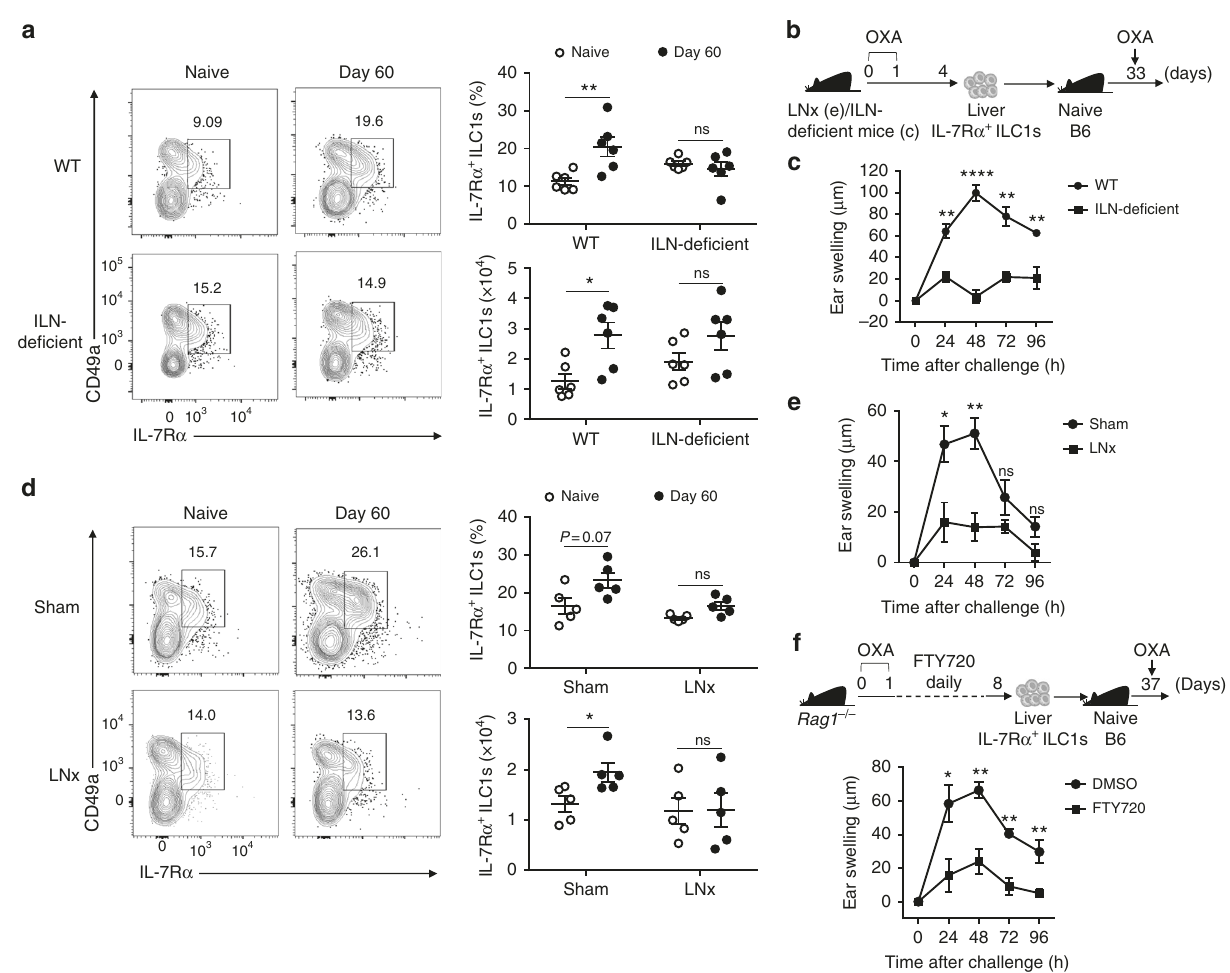
Fig. 6 Liver IL-7R α + ILC1-mediated memory responses are abolished in the absence of draining LNs. a ILN-de fi cient mice were sensitized with OXA and analyzed 2 months later. Representative dot plots (left panels) showing CD49a and IL-7R α expression on liver CD3 − NK1.1 + NKp46 + cells. Statistical analysis of results (right panels) showing the percentages and absolute numbers of liver IL-7R α + ILC1s. Data are pooled from two independent experiments ( n = 6 in each group). b Schematic of experiments for c , e . c Ear swelling of WT B6 mice that received 5 × 10 4 liver IL-7R α + ILC1s from OXA-sensitized (96 h) ILN-de fi cient mice and were challenged 1 month later. Data are pooled from two independent experiments ( n = 4 in each group). d WT B6 mice underwent surgical removal of ILNs (LNx) or sham operations and were subsequently sensitized with OXA. Two months later, the percentages and absolute numbers of liver IL-7R α + ILC1s were analyzed. Dot plots are of cells gated on CD3 − NK1.1 + . Data are pooled from two experiments ( n = 5 in each group). e CHS of naive B6 mice that received 5 × 10 4 liver IL-7R α + ILC1s from OXA-sensitized (96 h) LNx Rag1 − / − mice and were challenged with OXA 1 month later. Data are pooled from two experiments ( n = 6 in each group). f Rag1 − / − mice were sensitized (days 0, 1) with OXA and i.p. injected with FTY720 daily for 6 consecutive days (days 2 – 7). On day 8, 2 – 3 × 10 4 liver IL-7R α + ILC1s from FTY720-treated Rag1 − / − mice were adoptively transferred into naive B6 mice; recipient mice were then challenged with OXA and ear swelling was measured. Data are pooled from two independent experiments ( n = 3 – 6 in each group). Means ± SEM are shown. * P < 0.05, ** P < 0.01, **** P < 0.0001, two-tailed unpaired Student ’ s t (Fig. 5e), suggesting that the residency of LN-derived memory ILC1s in the liver is partly dependent on CXCR6.